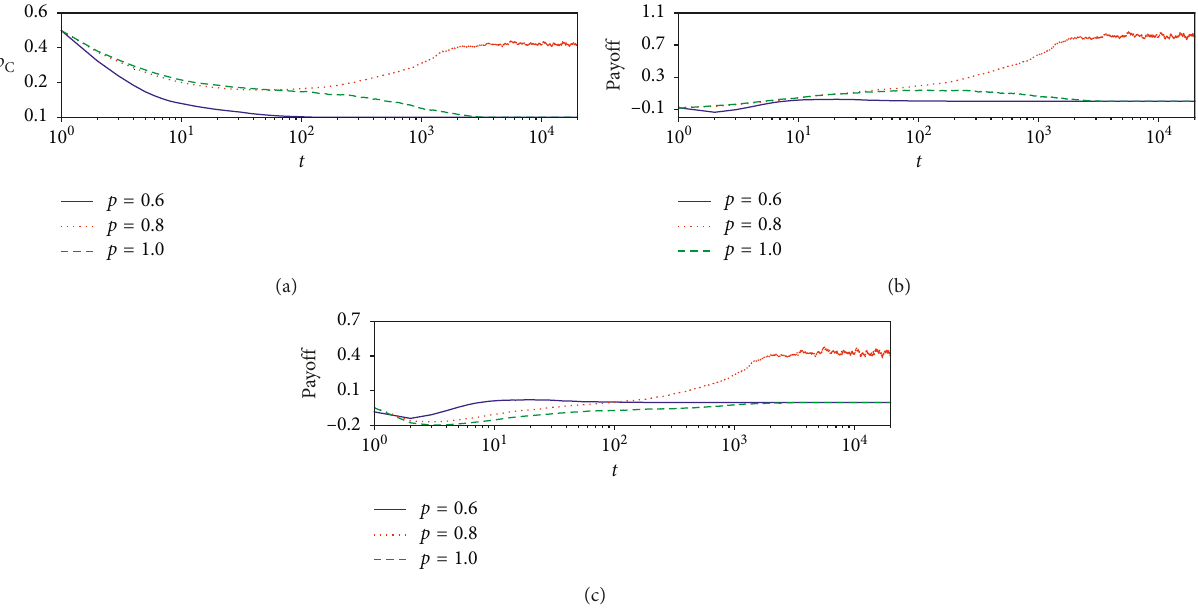
Figure 4: Time evolution of ρ , f dc , and f cd for different values of p as shown in panels (a), (b), and (c), respectively. C